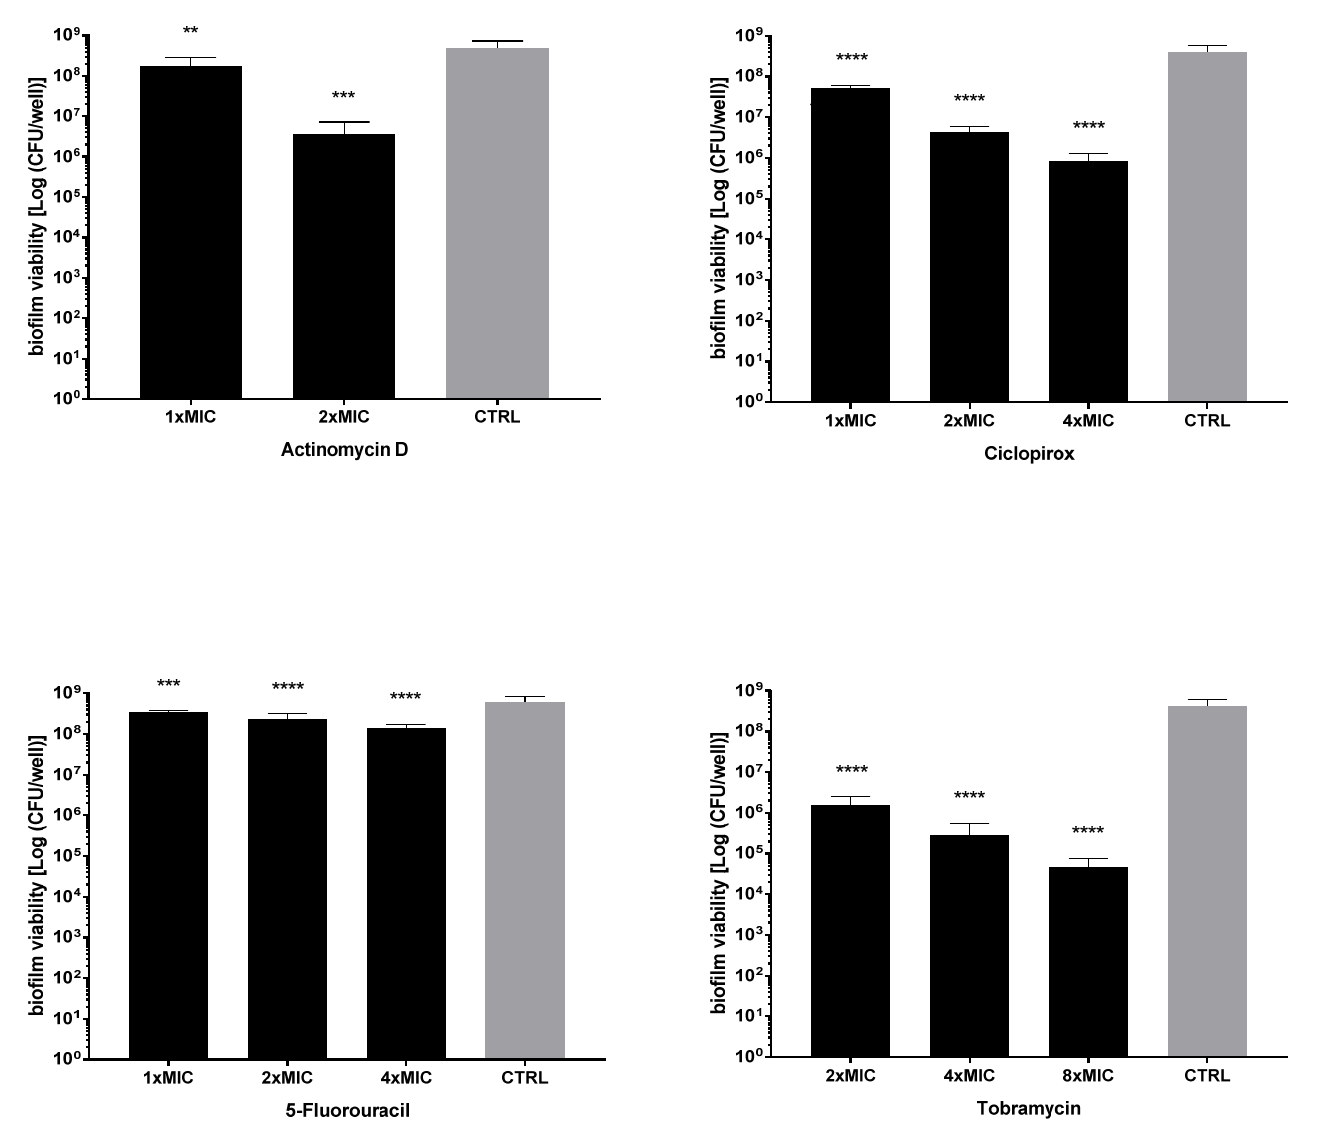
Figure 8. Killing activity against preformed biofilms by P. aeruginosa Pa7. The efficacy of actinomycin D, ciclopirox, and 5-fluorouracil on the viability of 24 h mature biofilms by P. aeruginosa Pa7 was assessed, comparatively to tobramycin, using cell viable count assay. Each drug was tested at multiples of MIC value. Results are expressed as mean + SD of the residual biofilm viability [Log (CFU/well)] after 24 h of exposure. Control samples (CTRL) were not exposed to the drug. Statistical significance at ordinary one-way ANOVA + Holm–Sidak’s multiple comparisons post-test: ** p < 0.01, *** p < 0.001, **** p < 0.0001 vs. CTRL.